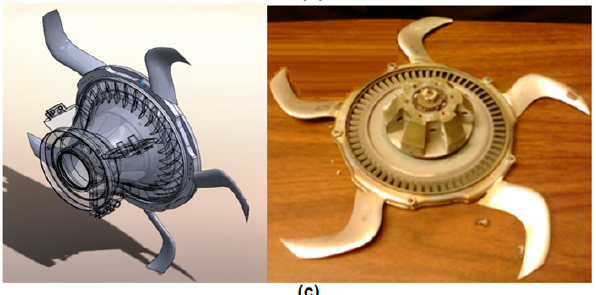
Figure 22. Vane and rotor of a turbine analyzed in MISES shown in ( a ), 3D RANS solution-based entropy in ( b ), and 3D-printed along with the matched machined propeller blades in ( c ).